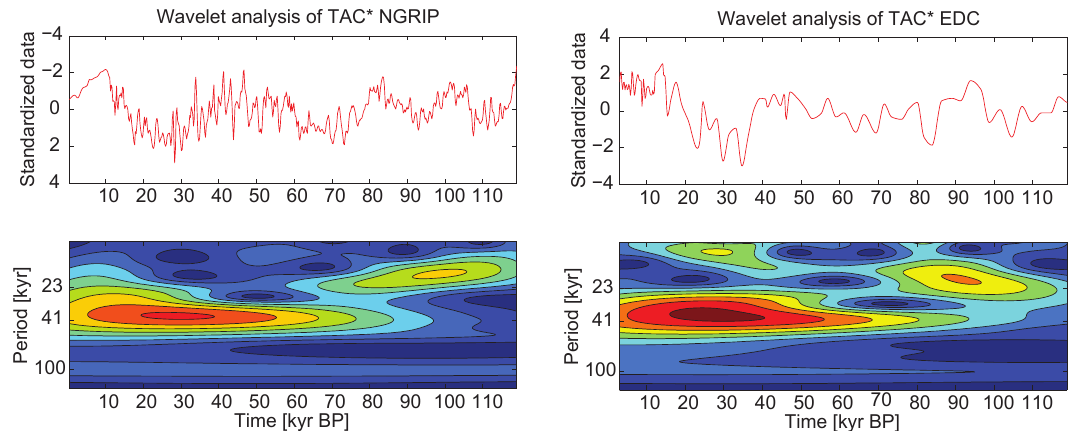
Figure 6. Left: the TAC ∗ data in red, resampled at an age step of 0.2kyr and wavelet analysis of this spline. Right: EDC TAC ∗ data (Raynaud et al., 2007), resampled at 0.2kyr and its wavelet analysis in the same time window.